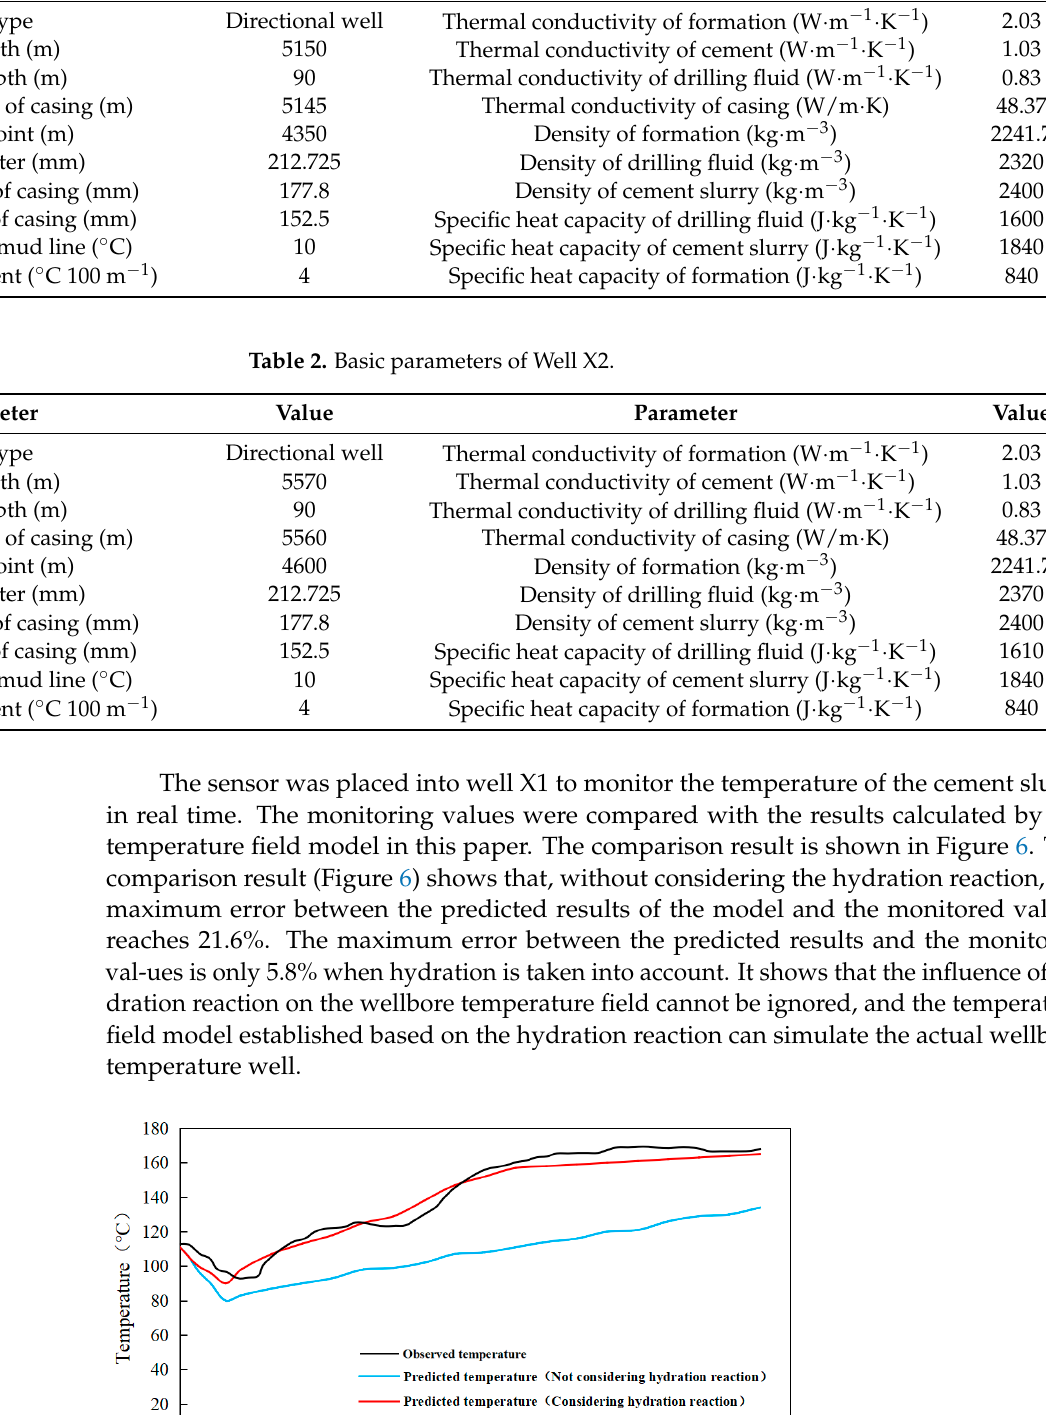
model based on the hydration reaction dynamics of cement slurry can better simulate the actual pressure loss of cement slurry and meet the demand of anti-channeling.